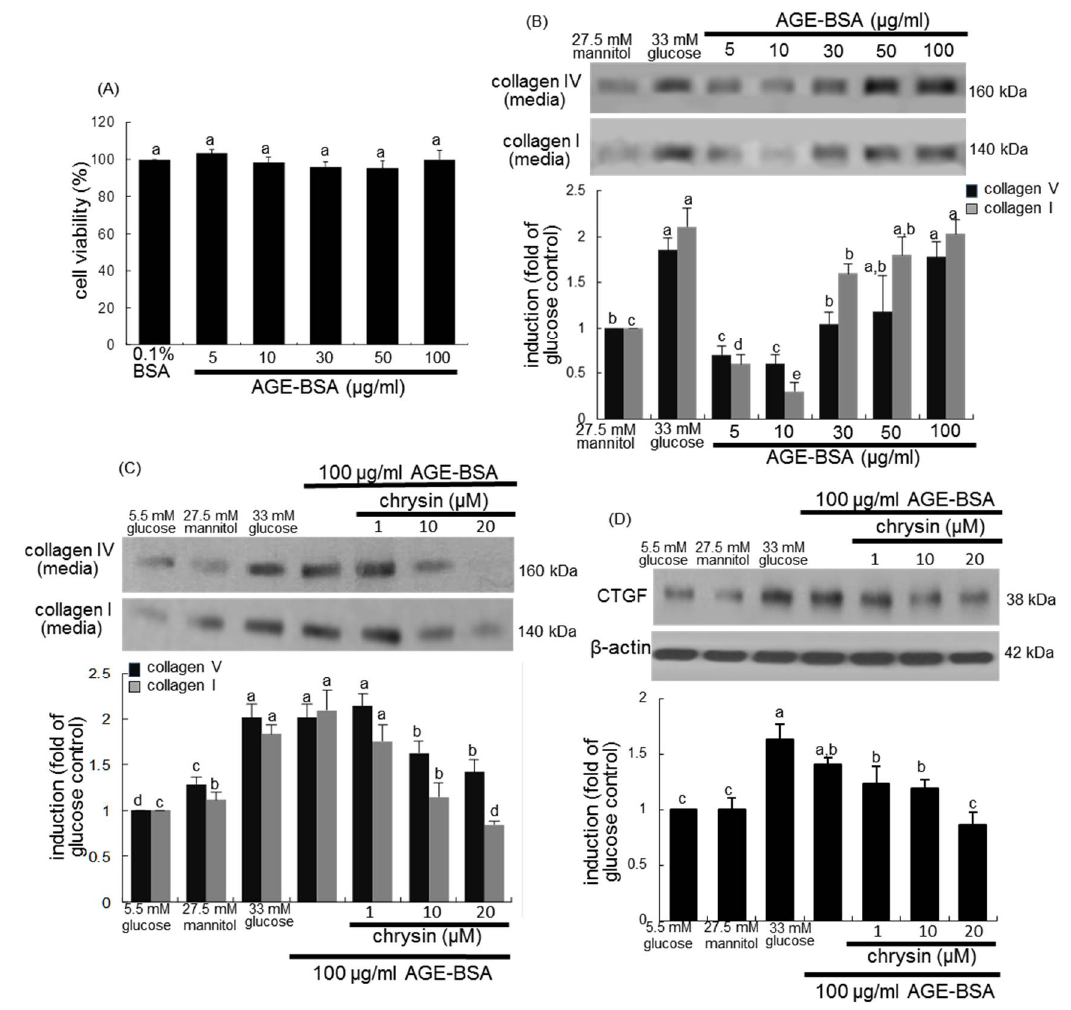
Figure 5. Cell viability ( A ) and collagen secretion ( B ) of 5–100 μg/mL AGE and inhibition of AGE-induced secretion of collagen I and collagen IV ( C ) and induction of CTGF ( D ) by chrysin. Human renal mesangial cells were challenged for 3 days with 5–100 μg/mL AGE-BSA in the absence and presence of 1–20 μM chrysin. Values of cell viability measured by MTT assay are mean ± SEM ( n = 5) and expressed as percent cell survival relative to 0.1% BSA (A, cell viability = 100%). Cell extracts and media were subject to Western blot analysis with a primary antibody against collagen I, collagen IV and CTGF. β-Actin protein was used as an internal control. The bar graphs in the bottom panel represent densitometric results obtained from Image analysis. Values in bar graphs (mean ± SEM, n = 3 independent experiments) not sharing a same lower case indicate significant different at p < 0.05.